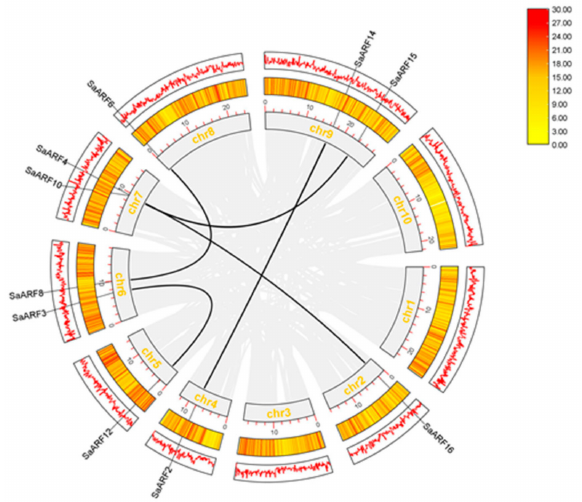
Figure 7. Interchromosomal relationship of the ARF gene in S. album . The gray lines indicate synteny blocks in the S. album genome, and the black lines indicate synteny blocks where the ARF repeat gene pairs are located. Chromosome names are shown in the middle of each chromosome, and the unit of chromosome length is Mbp. The golden yellow circle is the heatmap of gene density, and the outermost circle is the line map of gene density.